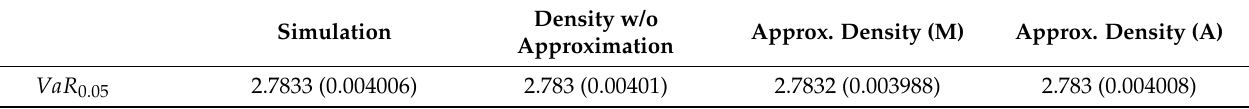
Figure 8. Case 1: Density and histogram for ln ( Π ( T )) . Table 10. VaR 0.05 for ln ( Π ( t )) from four